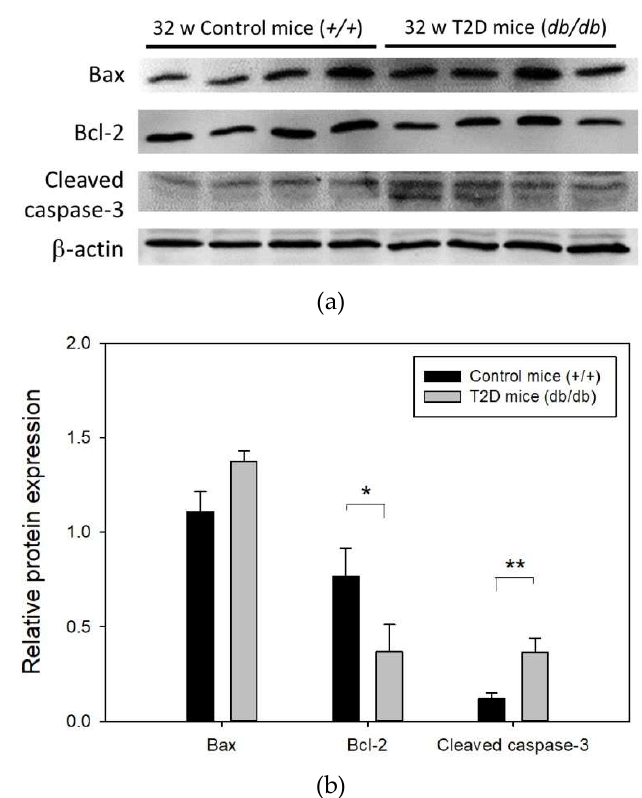
Figure 5. ( a ) Representative western blot image of apoptosis related protein expression in T2D and control mouse retina ( b ) Results of Bax, Bcl-2, and cleaved caspase-3 expression in mouse retina normalized to that of the internal control, β-actin. Data are presented as mean ± SD. * p = 0.008, ** p = 0.025 ( t -test). w: weeks.